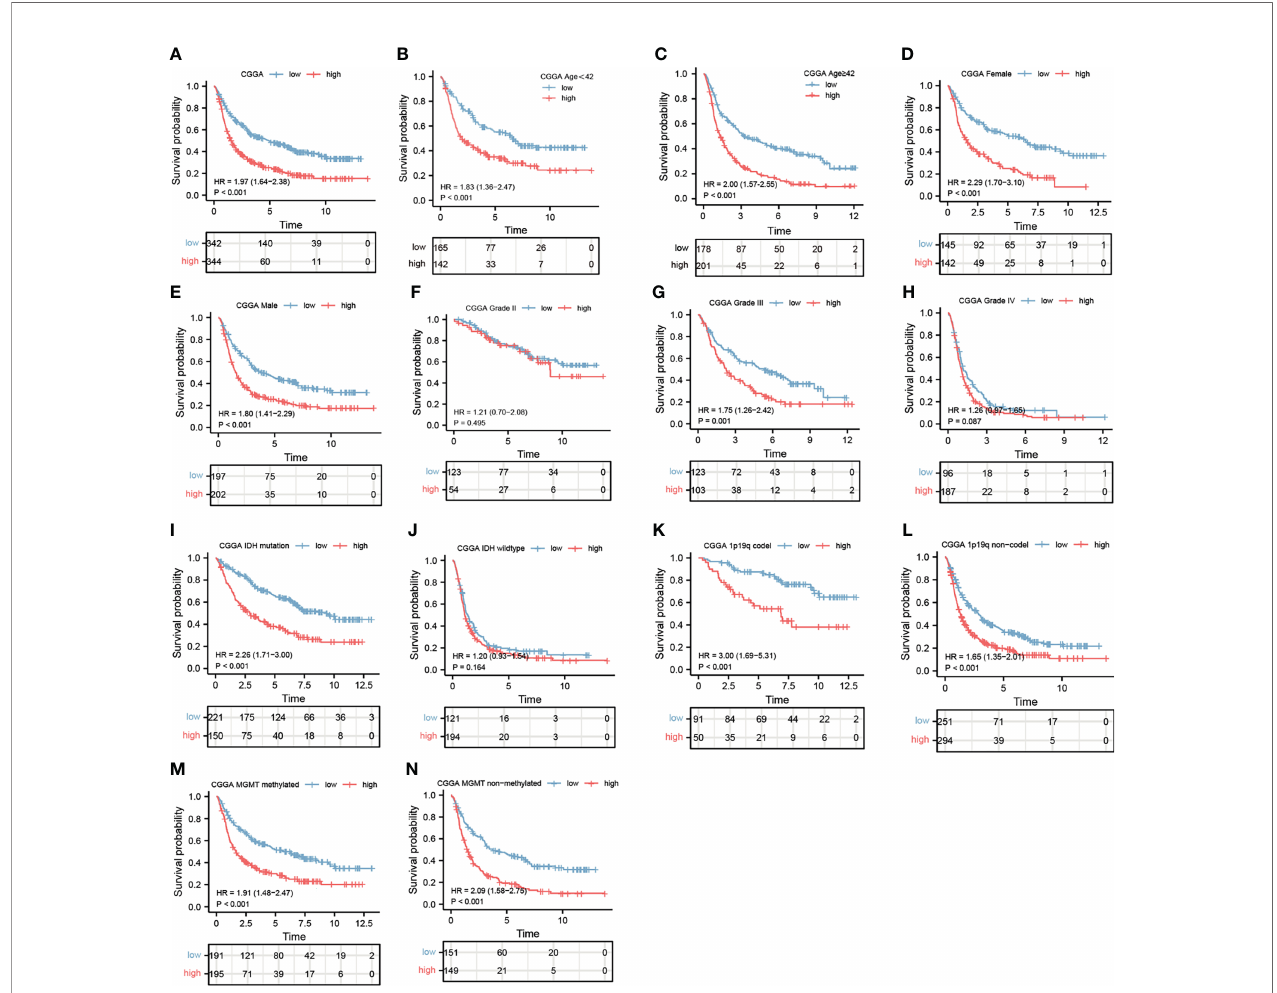
FIGURE 3 | Prediction of the outcome of IGHG1 in strati fi ed patients in the Chinese Glioma Genome Atlas (CGGA) dataset. (A) Survival curve used to analyze overall survival (OS) in the low- and high- IGHG1 groups in the CGGA dataset. (A – N) Survival analysis of the signature in patients strati fi ed by age (B, C) , gender (D, E) , grade (F, H) , isocitrate dehydrogenase (IDH) status (I, J) , 1p19q status (K, L) , and O 6 -methylguanine-DNA methyltransferase (MGMT) promoter (M, N)